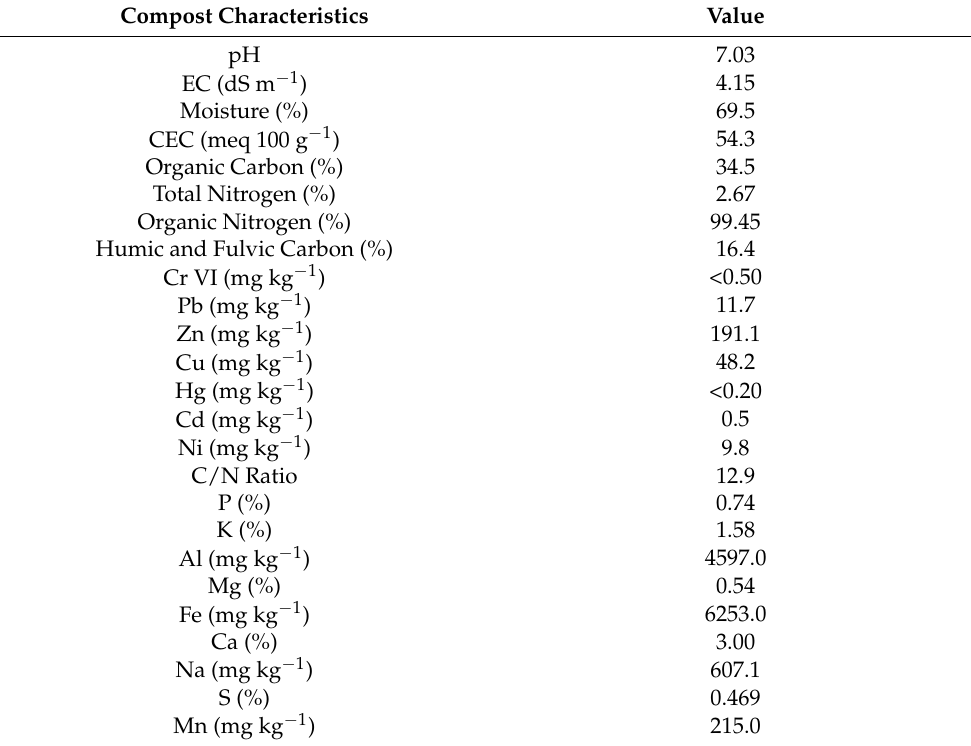
Table 1. Chemical characteristics of the compost. All values as dry